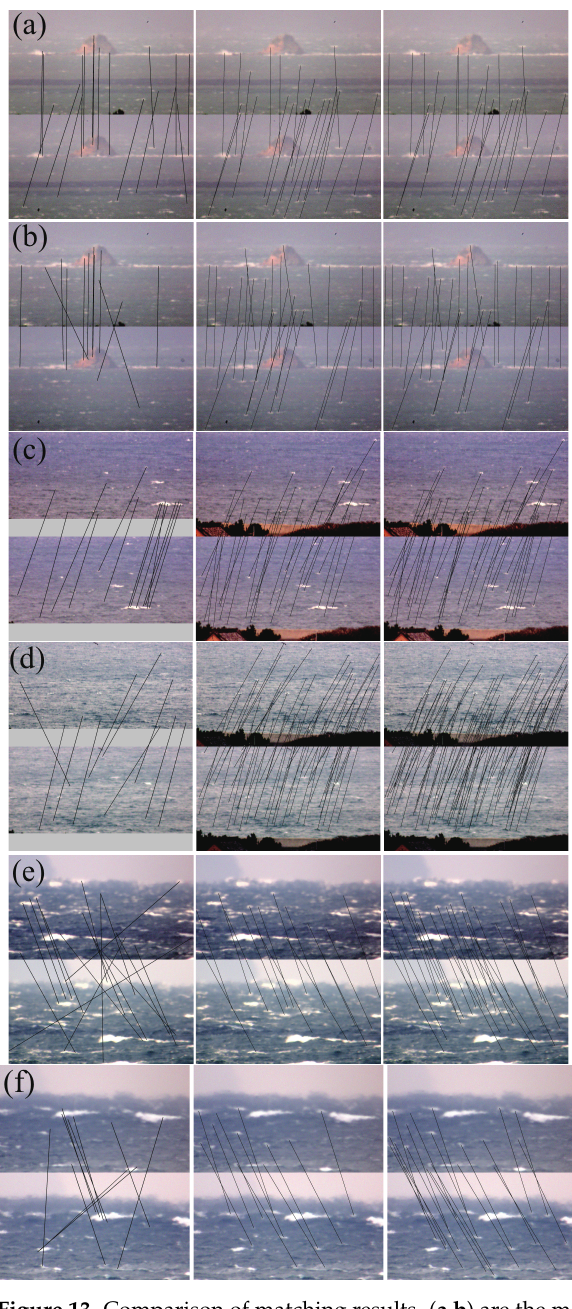
Figure 13. Comparison of matching results. ( a , b ) are the matching results taken in Sep 2022 from FIT with monitoring distance of 0.8–1.4 × 10 4 m, ( c , d ) are the matching results taken in Mar 2017 from FIT with monitoring distance of 0.4–1.0 × 10 4 m, ( e , f ) are the matching results taken in Feb 2016 from FKSH with monitoring distance of 1.4–2.0 × 10 4